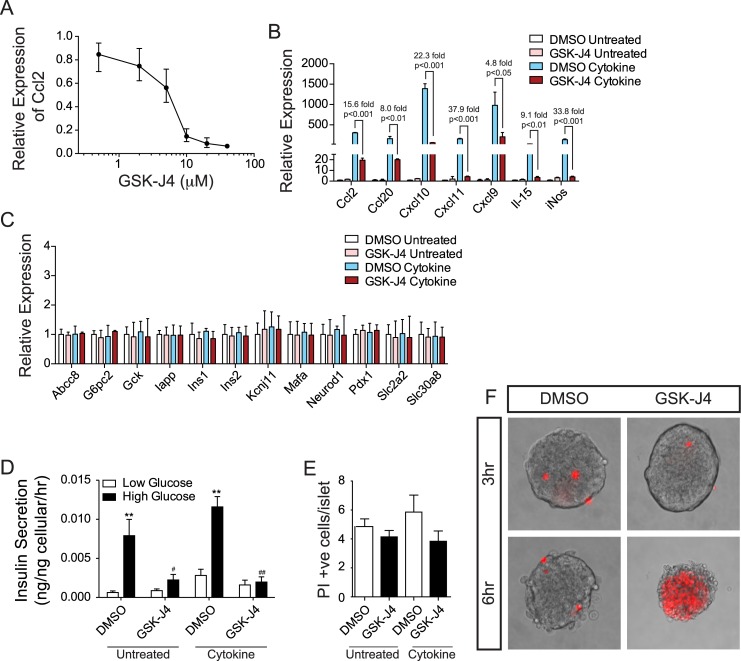
The small molecule GSK-J4, an inhibitor of Jmjd3 and Utx, significantly blunts IFNγ, Il-1β, and TNFα-induced chemokine gene expression in islets.(A) A dose-response curve of Ccl2 expression in islets exposed a titration of concentrations of GSK-J4 as determined by qPCR. (B) Expression of selected chemokine and cytokine genes in islets exposed to 20μM GSK-J4 or a vehicle control (DMSO) and simultaneously untreated or treated with IFNγ, Il-1β, and TNFα (cytokine) as determined by qPCR. (C) Expression of selected genes involved in regulating β-cell function in islets exposed to 20μM GSK-J4 or a vehicle control (DMSO) and simultaneously untreated or treated with IFNγ, Il-1β, and TNFα (cytokine) as determined by qPCR. (D) Glucose-induced insulin secretion assays of islets exposed to 20μM GSK-J4 or a vehicle control (DMSO) and simultaneously untreated or treated with IFNγ, Il-1β, and TNFα (cytokine) as determined by qPCR. (E) Propidium iodide (PI) incorporation in islets exposed to 20μM GSK-J4 or a vehicle control (DMSO) and simultaneously untreated or treated with IFNγ, Il-1β, and TNFα (cytokine) as determined by qPCR. (F) Representative images of islets treated with DMSO or GSK for three and six hours respectively. PI positive cells are marked in red.